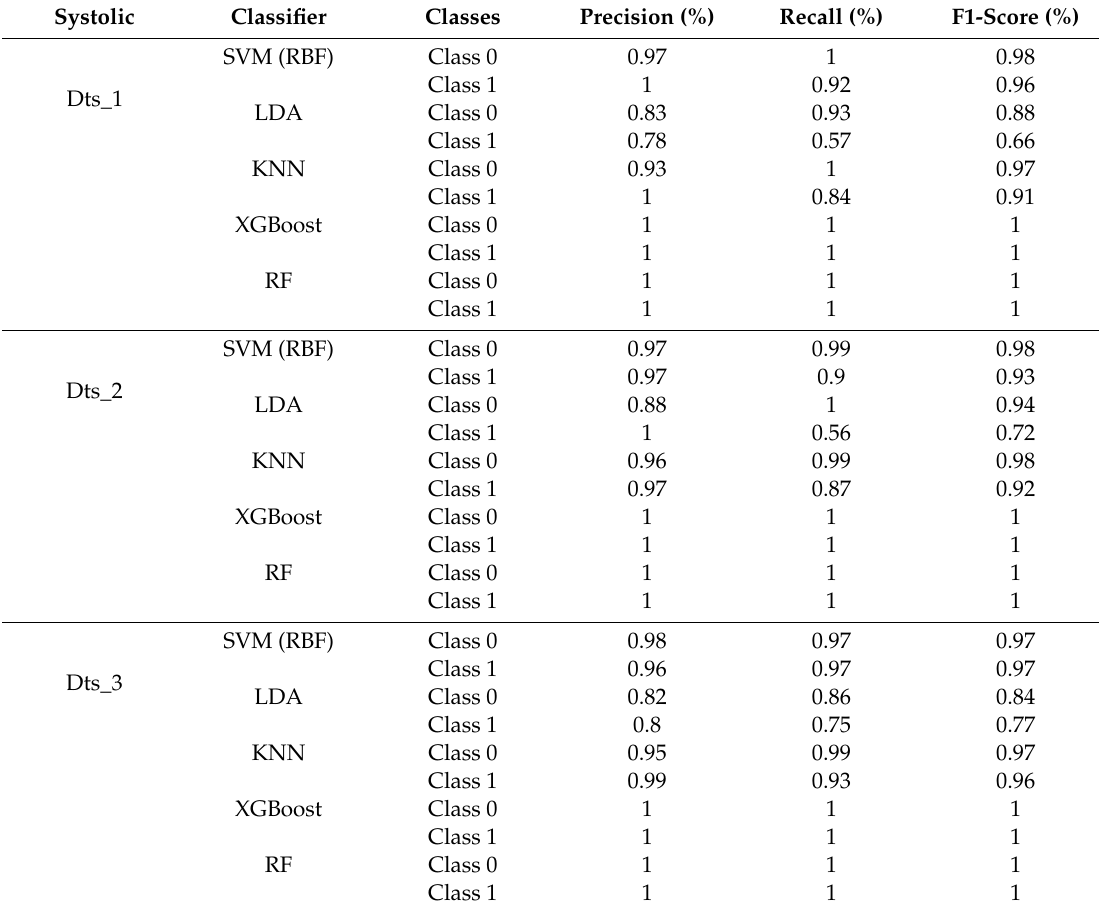
Table 6. Comparative classification results using the standards